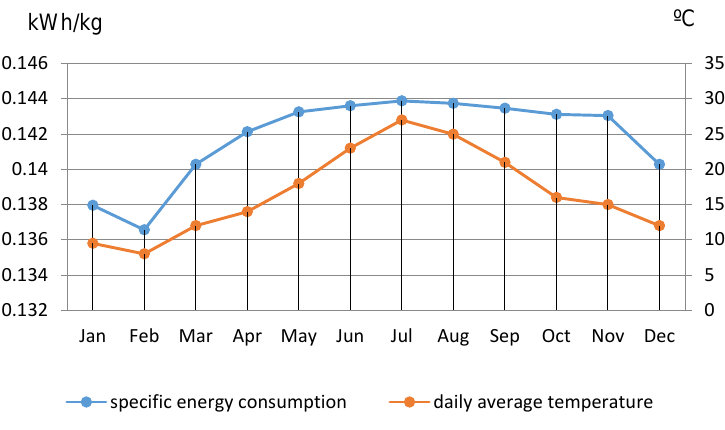
Figure 9. Electricity consumption for different supply levels.